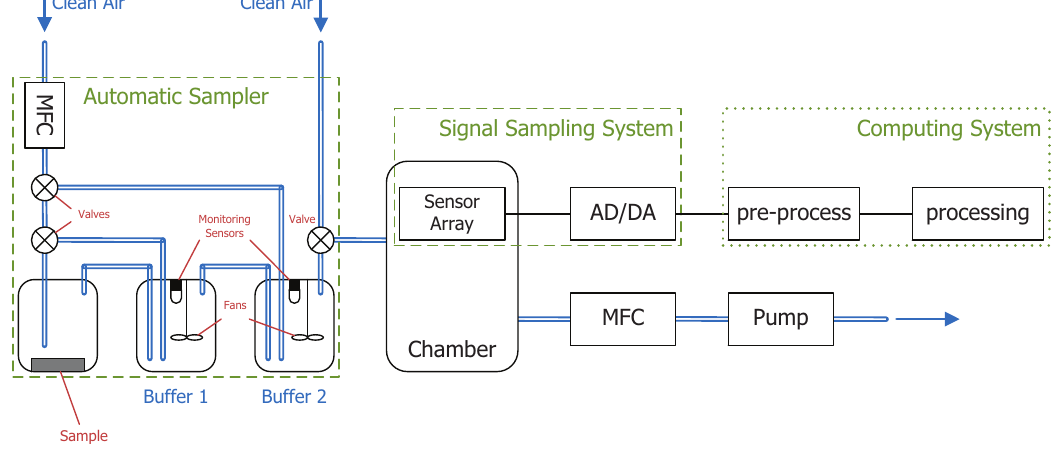
Figure 3. Gas/odor concentration measurement system with an automatic